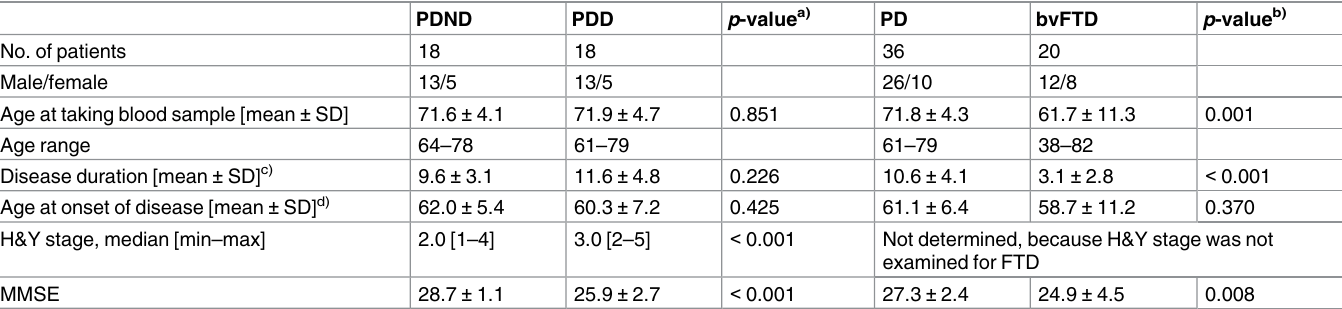
Table 1. Patient characteristics.